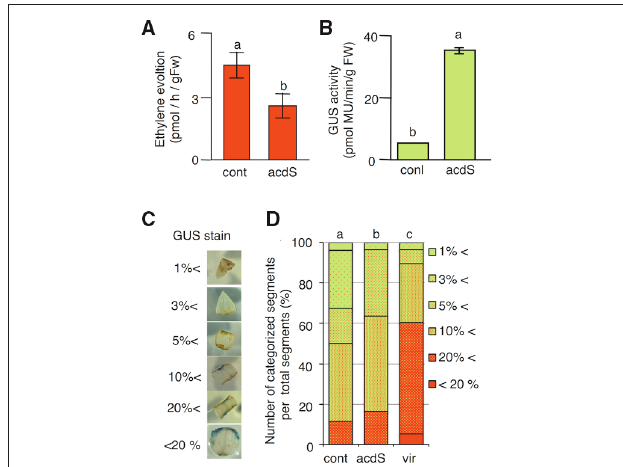
FIGURE 2 | Agrobacterium tumefaciens with ACC deaminase activity inhibits ethylene evolution during co-cultivation, increasing gene transformation frequency in tomatoes and melons. (A) Measurement of ethylene evolution. The accumulation of ethylene in the headspace was measured on a gas chromatograph. Bars represent standard deviations ( n = 3). The characters a and b show significant differences ( t -test; P < 0.05). fw, fresh weight. (B) Quantification of gene transfer by a GUS assay. Melon cotyledon segments were co-cultured with three different A. tumefaciens strains for 3 days. (C) Classification of GUS-stained cotyledon explants. GUS-stained tomato cotyledons were categorized based on the stained area: less than 1, 1–3, 3–5, 5–10, 10–20, and more than 20%. (D) The frequency of each GUS staining category in tomato explants. Bacterial strains with significant differences (Student’s t -test and Kruskal–Wallis test; P < 0.01) are indicated by different letters. cont: A. tumefaciens GV2260 (pBBR1MCS-5, pIG121); acdS: A. tumefacien s GV2260 (pBBR acdS , pIG121-Hm) acdS gene driven by lac promoter; virD1acdS: A. tumefaciens GV2260 (p virD1acdS , pIG121-Hm)